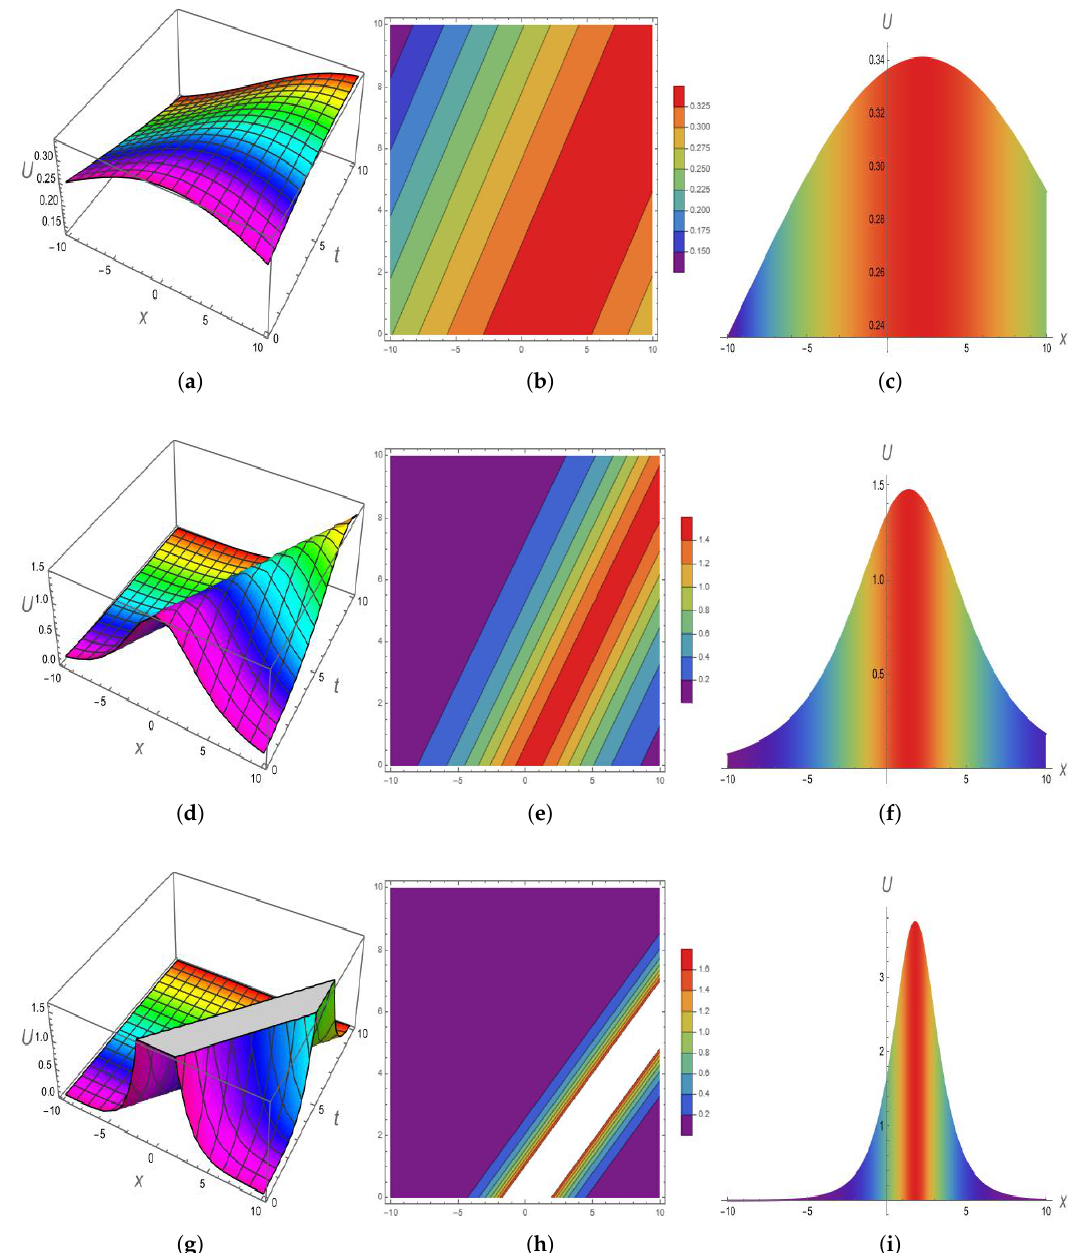
Figure 5. Three-dimensional, contour, and 2-D profiles for the real part of solution £ 18 for different values of parameter k . ( a ) Three-dimensional propagation at k = 0.3; ( b ) Contour propagation at k = 0.3; ( c ) Two-dimensional propagation at k = 0.3; ( d ) Three-dimensional propagation at k = 1.3; ( e ) Contour propagation at k = 1.3; ( f ) Two-dimensional propagation at k = 1.3; ( g ) Three-dimensional propagation at k = 3.3; ( h ) Contour propagation at k = 3.3; ( i ) Two-dimensional propagation at k =